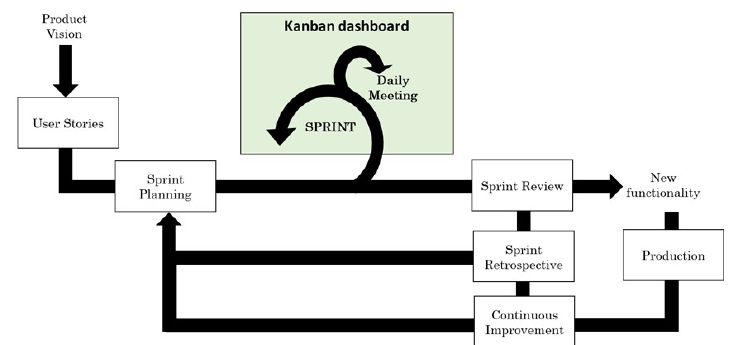
Figure 6. Scrumban